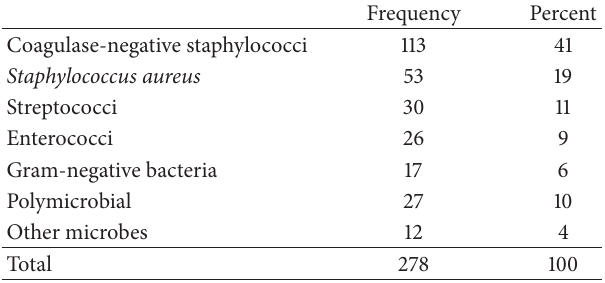
Table 2: Type of